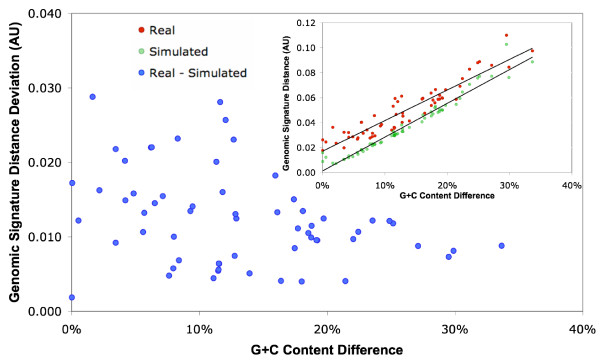
Difference in genomic signature distance between real and randomized data for LDV-host pairs. The inset figure shows the genomic signature distances between the LDV-host pairs for both real and randomized data.